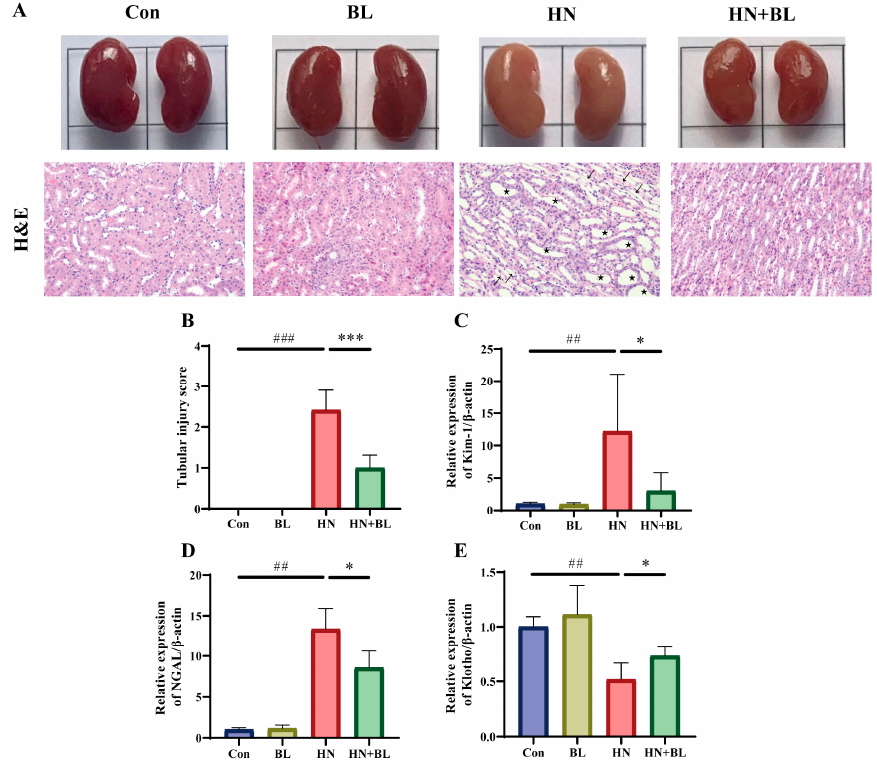
Figure 2. Effect of BL on renal histopathology in mice with HN. ( A ) The appearance and the H&E staining photomicrographs of the kidneys. ( B ) The semiquantitative scoring of the tubular injury in the H&E ‐ stained kidney slides. ( C ‐ E ) The relative mRNA expression levels of early renal injury biomarkers Kim ‐ 1, NGAL, and Klotho. Pentagon: renal tubule dilatation. Arrow: inflammatory cell infiltration. Data represent mean ± SD ( n = 6). ## p < 0.01, ### p < 0.001 vs. the Con group; * p < 0.05, *** p < 0.001 vs. the HN group.